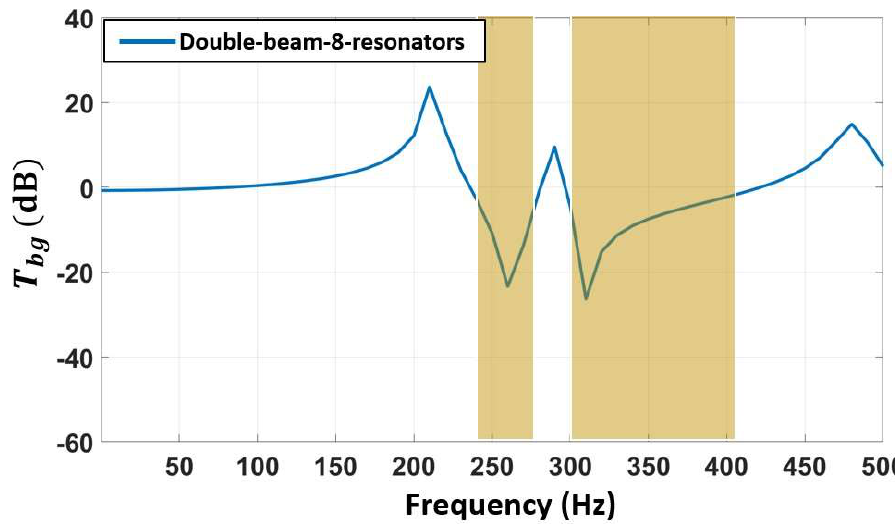
Figure 6. Transmissibility and frequency bandgaps generated from model simulations of a double- layered beam-type metamaterial structure with 8 resonators and using the parameters shown in Table 1. Results show two significant frequency bandgaps, i.e., 238–275 Hz and 300–410 Hz, marked by the shaded area.